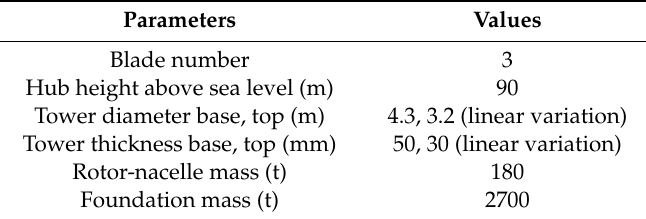
Figure 3. The finite element model (FEM) of OWT supported by bucket foundation. Table 1. Physical parameters of the NREL 3 MW wind turbine.